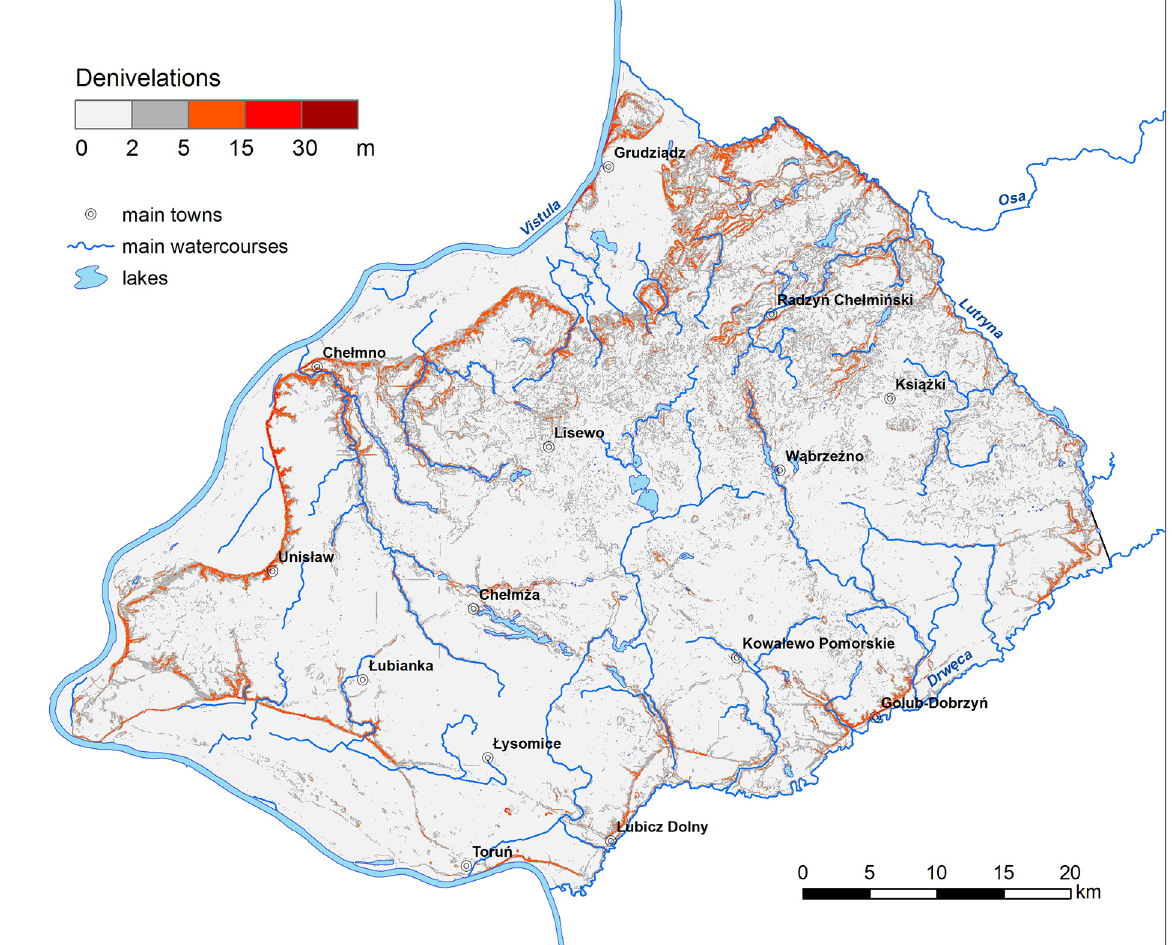
Fig. 4. Relative altitude